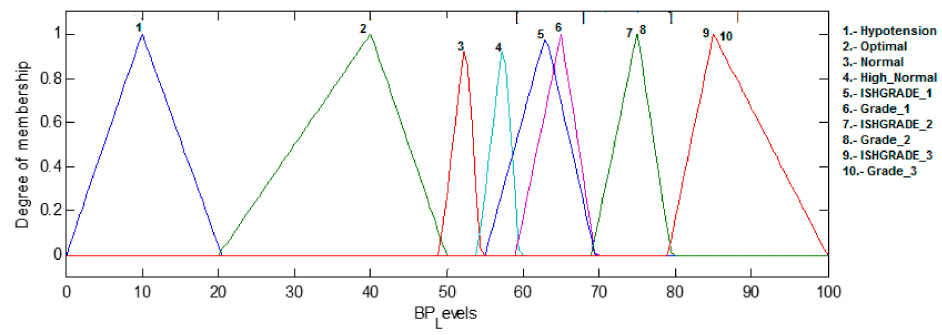
Figure 19. BP_Levels is the output of the fuzzy logic classifier